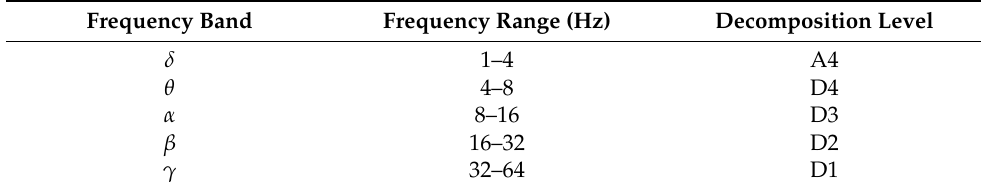
Table 1. EEG signals